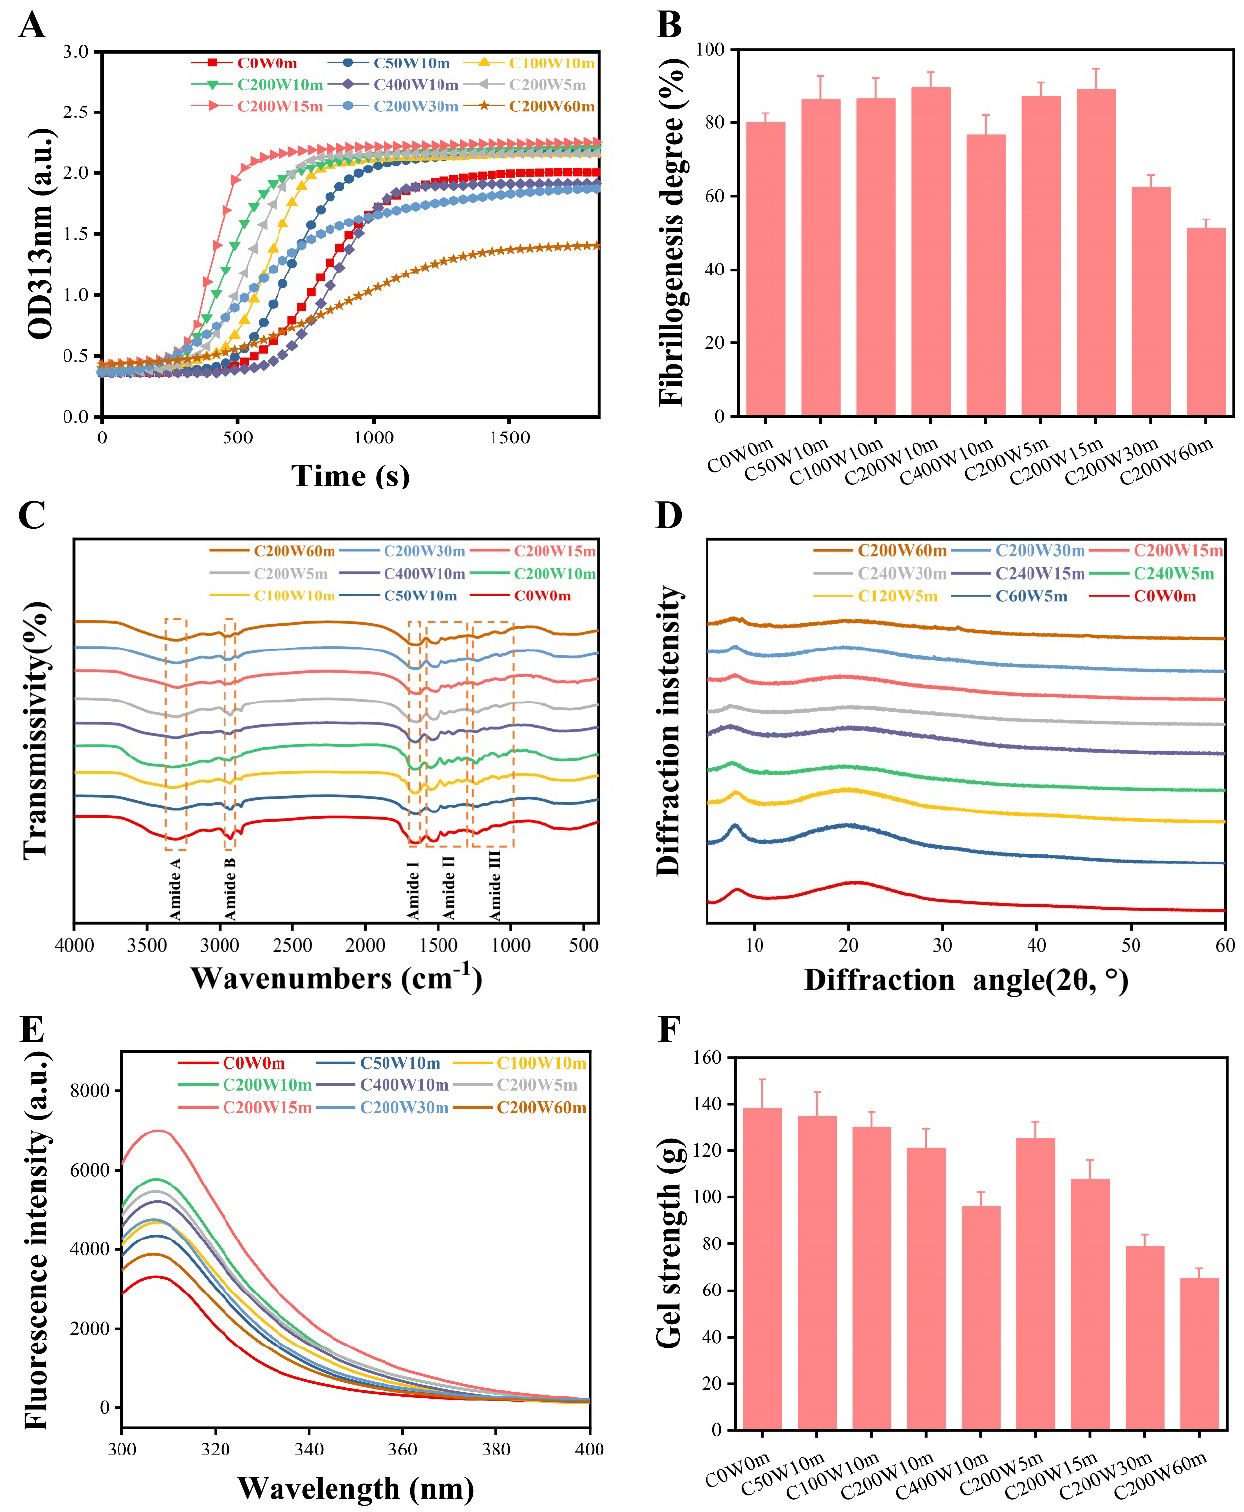
Figure 1. Turbidity assay ( A ), fibrillogenesis degree ( B ), fourier transform infrared spectroscopy ( C ), X-ray diffraction spectra ( D ) and fluorescence emission spectra ( E ) of collagen; gel strength of collagen fibril gels ( F ).